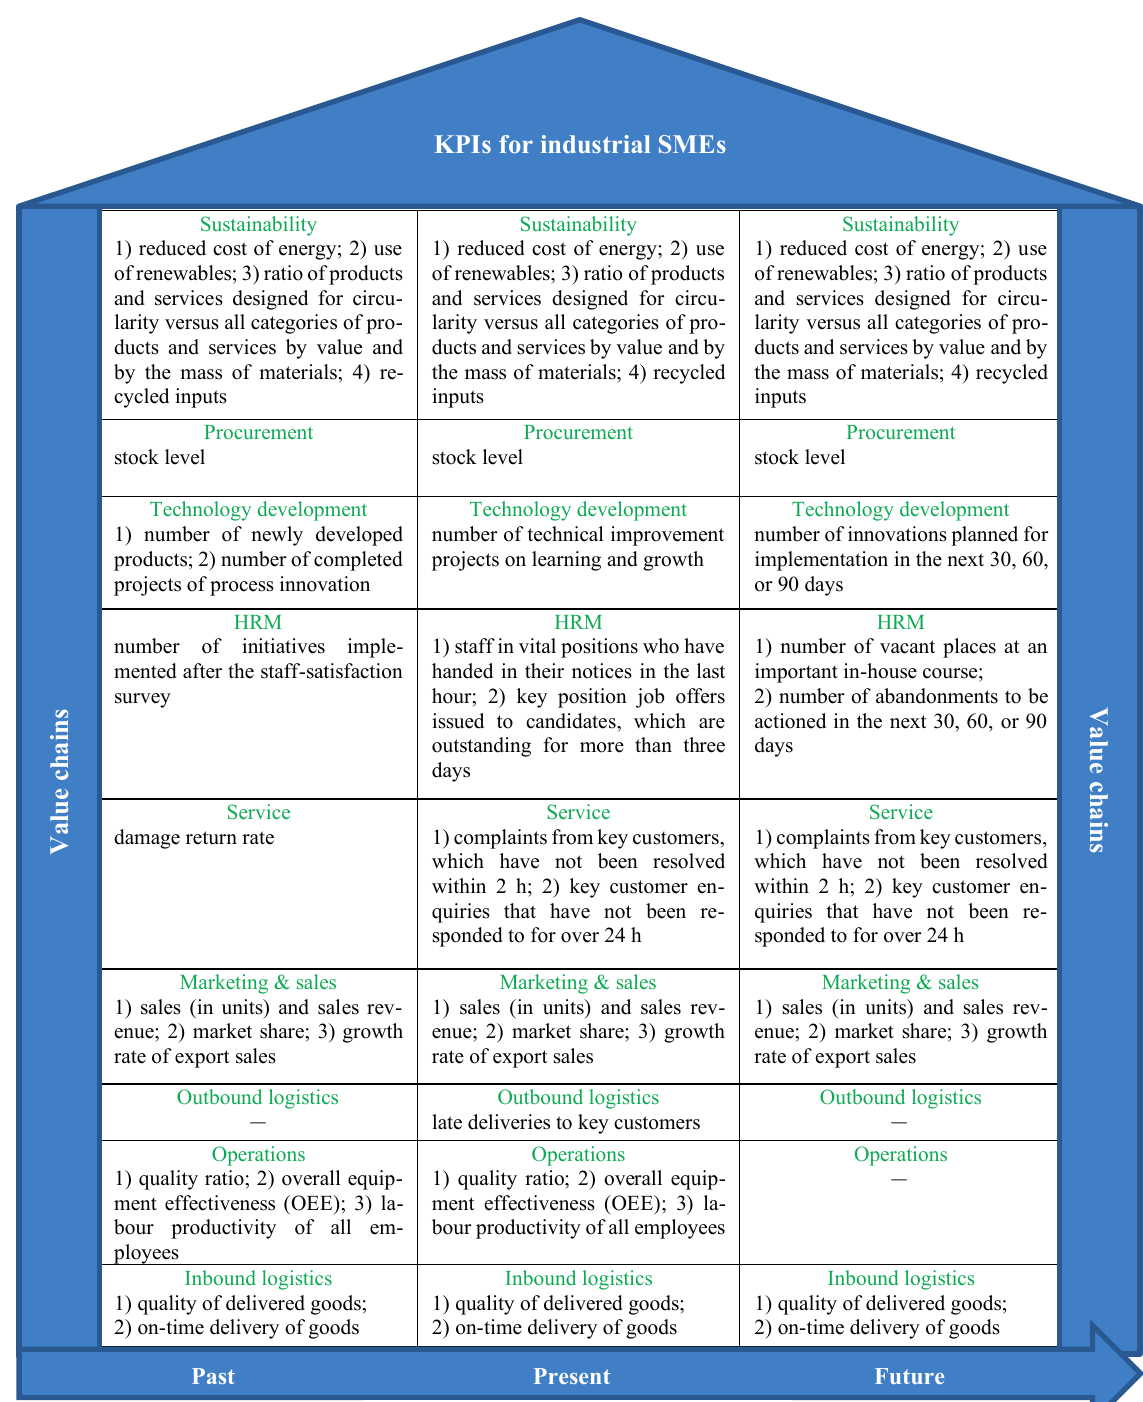
Fig. 1. KPIs model for industrial SMEs.